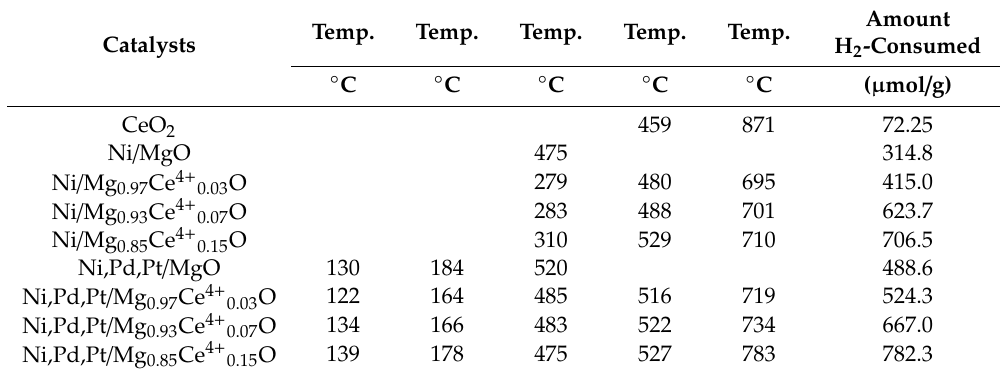
Figure 5. N 2 adsorption / desorption isotherms ( A ) and pore size distributions ( B ) of Ni,Pd,Pt / Mg 0.85 Ce 4 + 0.15 O catalyst. Table 3. The di ff erent catalysts and their H 2 -TPR values (reduced in a 5% H 2 / Ar stream at a 10 ◦ C / min temperature